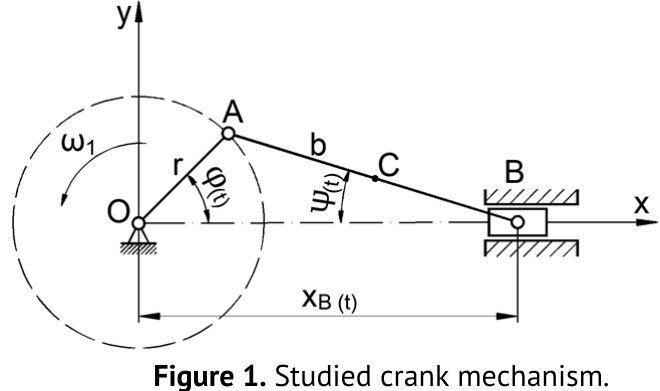
Figure 1. Studied crank